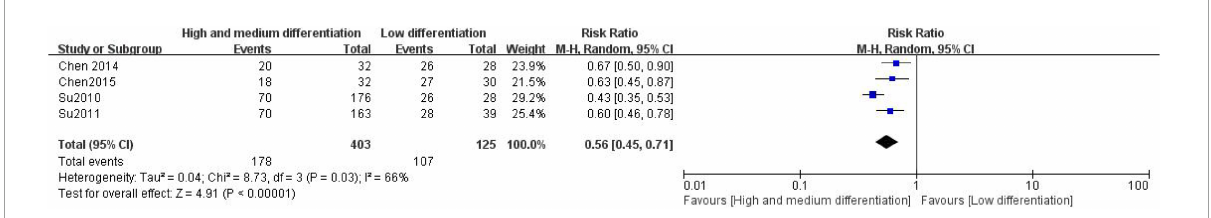
FIGURE2 Forest map of correlation between CD24 expression and high-level nuclear classification.